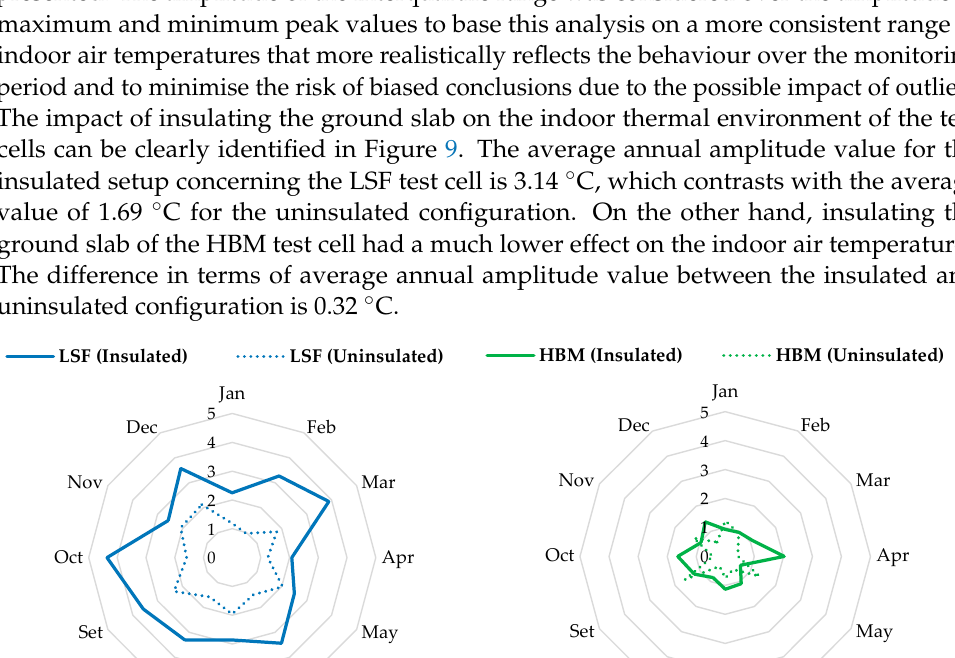
Figure 9. Monthly indoor air temperature amplitude for the insulated and uninsulated experimental setups (°C).